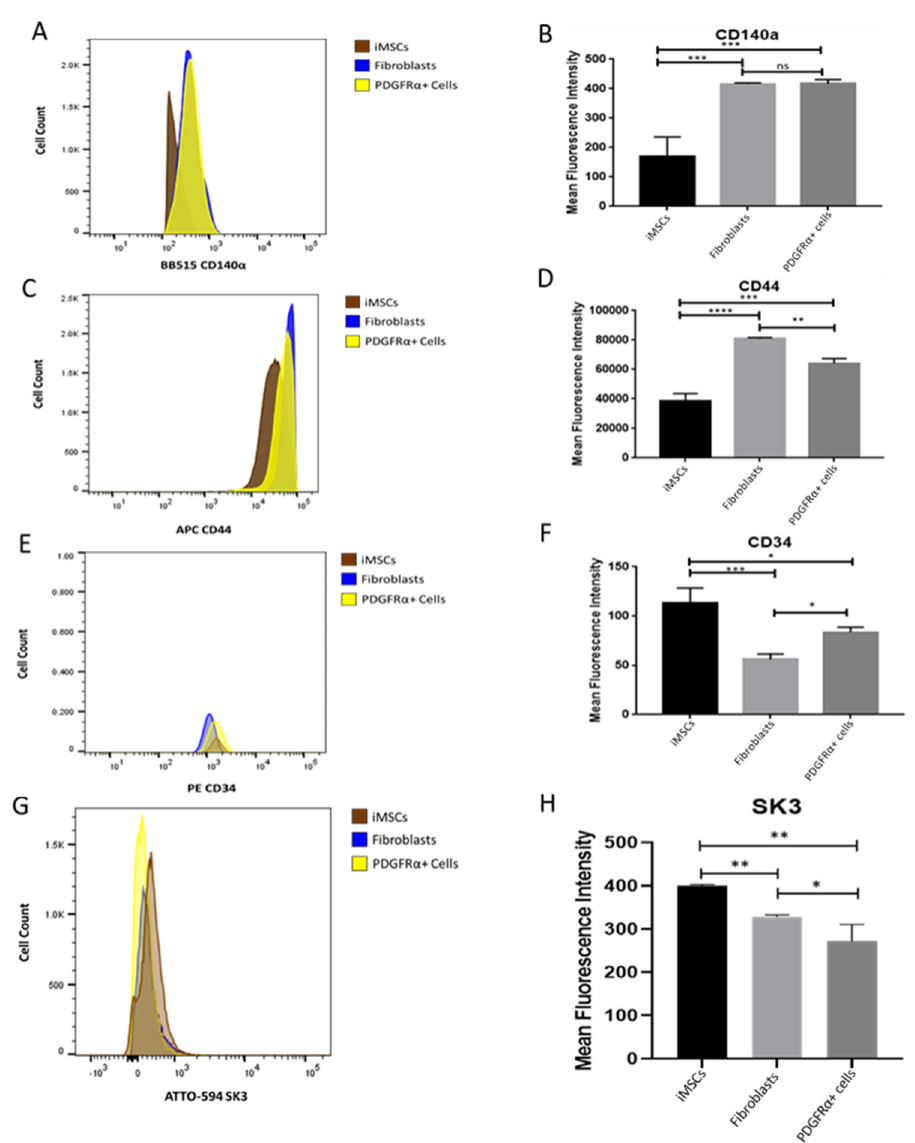
Figure 6. Expression of CD140 α , CD44, CD34 and SK3 cell surface markers in iMSCs, fibroblasts, and PDGFR α -positive cells. Flow cytometry analysis detected the expression of CD140 α (( A ). cell count; ( B) . mean fluorescence intensity), CD44 (( C ). cell count; ( D ). mean fluorescence intensity), CD34 (( E ). cell count; ( F ). mean fluorescence intensity), and SK3 (( G ). cell count; ( H ). mean fluorescence intensity) in iMSCs, fibroblasts, and PDGFR α -positive ( n = 3, * p < 0.05, ** p < 0.01, *** p < 0.001, **** p < 0.0001); ns: not significant.